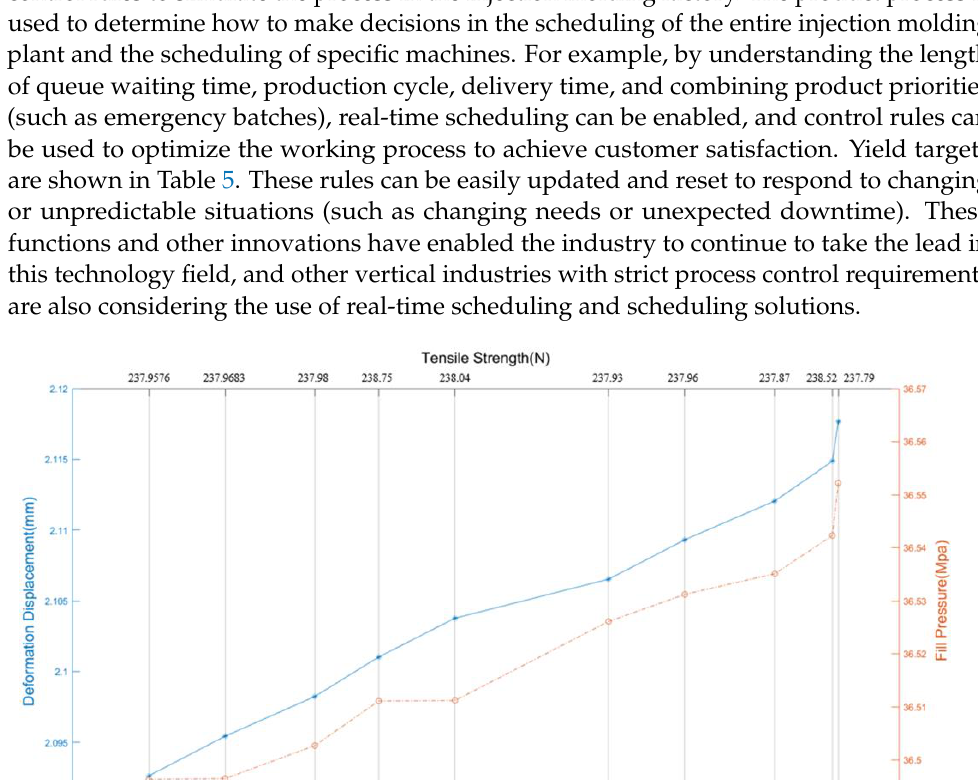
Table 5. VM and RPM control corresponding values.